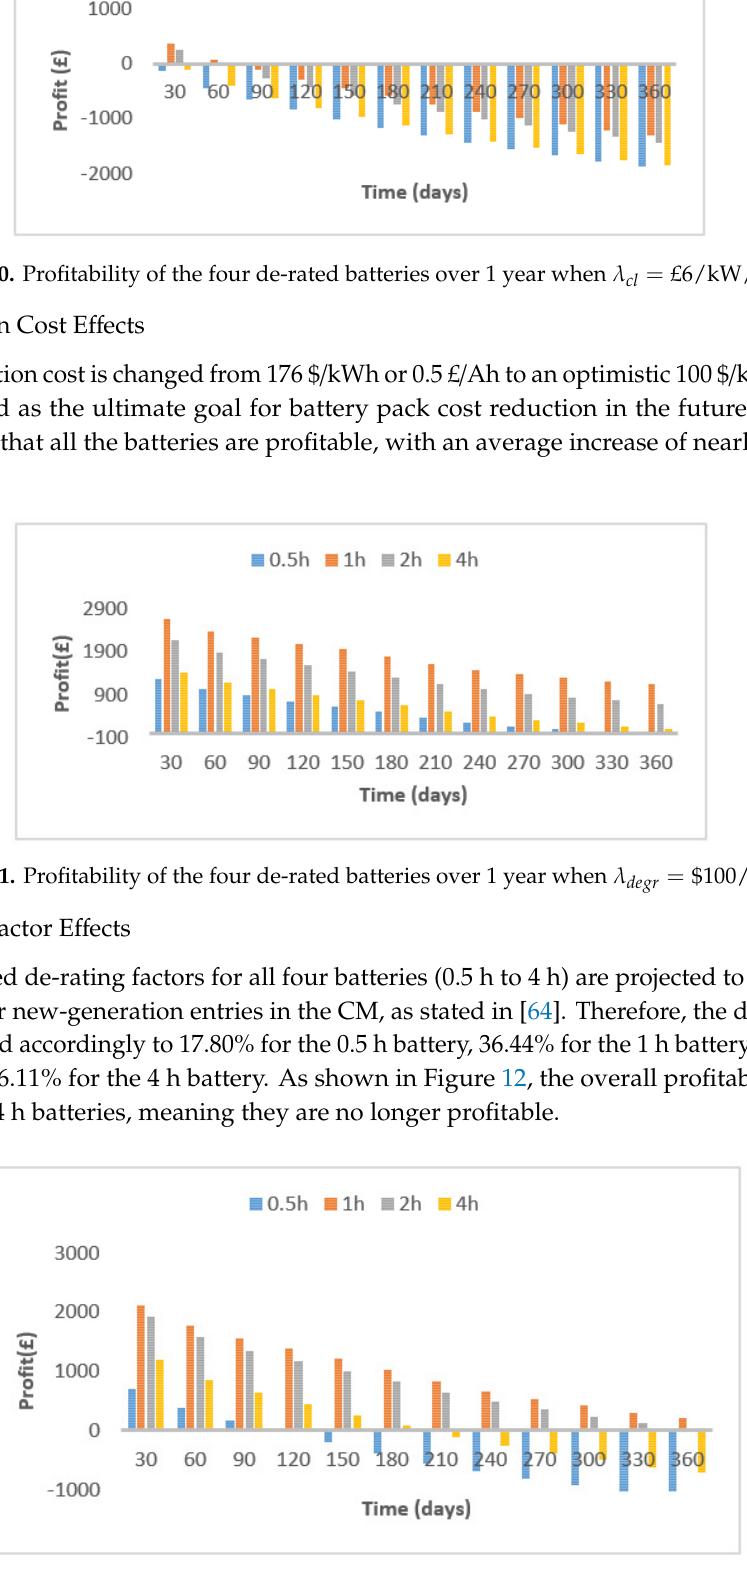
Figure 12. Profitability of the four de-rated batteries over 1 year with changes to the de-rating factors.